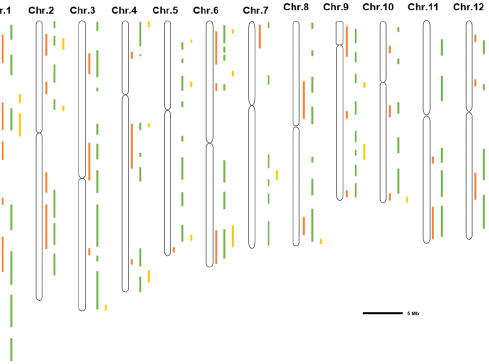
Figure 1. Distribution of salt stress-related QTLs/QTNs detected by GWAS on 12 chromosomes (Chr) of rice. The 12 long columns represent the 12 chromosomes of rice, respectively. The orange, green and yellow bars represent QTLs/QTNs positions detected at the stages of germination [31– 34], seedling [34,35–38,40–43,45,46,51,52] and reproductive [47–50], respectively. The length of the black line in the lower right corner of the figure represents the physical distance of the chromosomes.